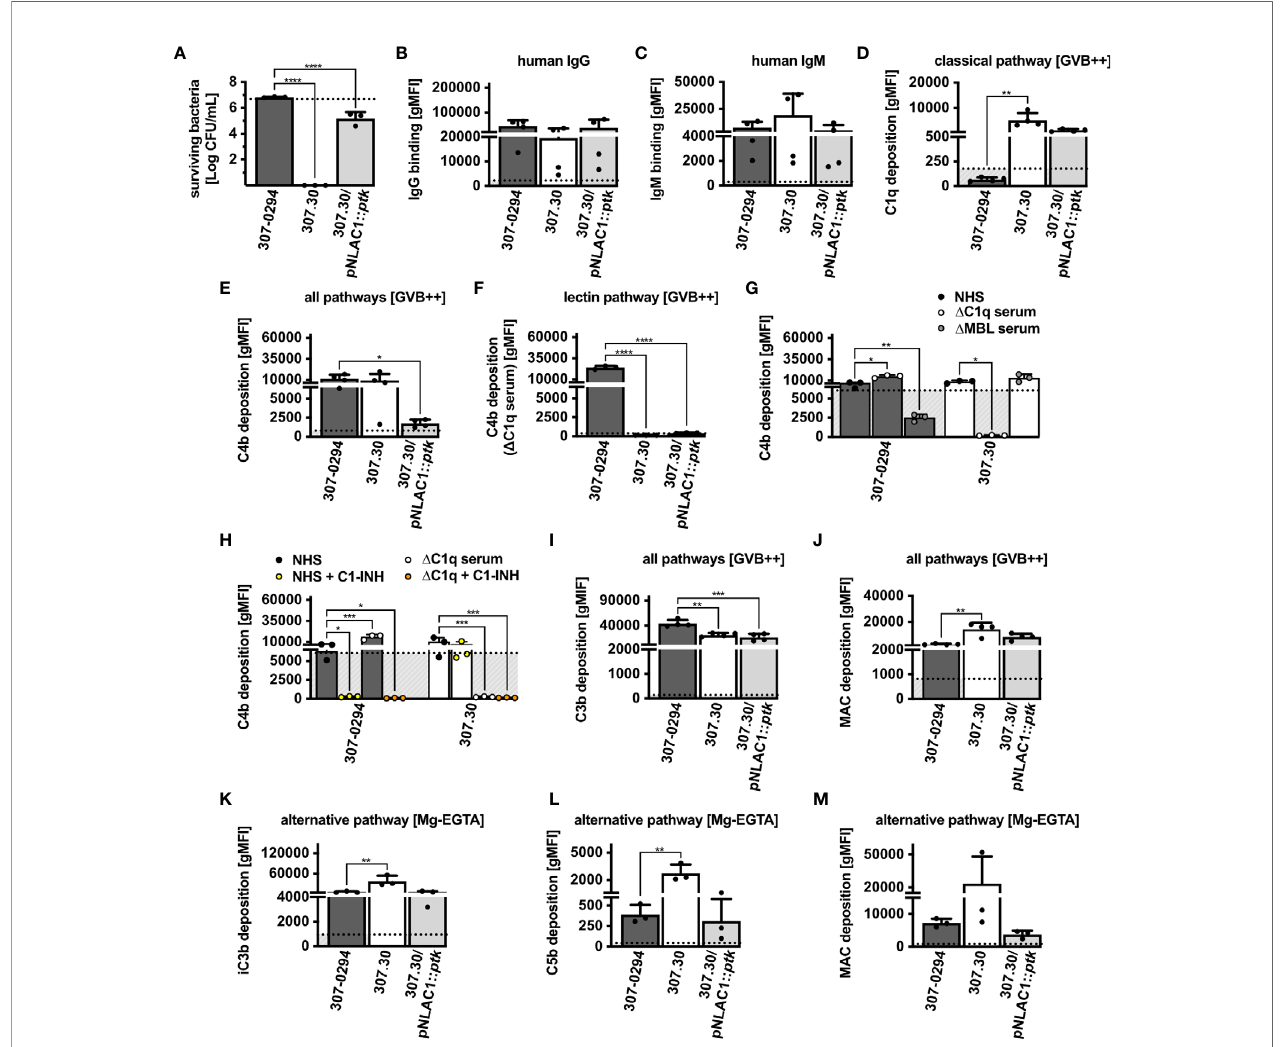
FIGURE 4 | Survival and complement system activation on A. baumannii mutant strains. (A) Survival of wt and capsule mutant strains in 30% NHS. Binding of human (B) IgG and (C) IgM. (D) Deposition of C1q. Deposition of C4b in (E) NHS, (F) human C1q-depleted serum, (G) NHS, human C1-depleted serum and MBL- depleted serum, (H) the presence of C1-INH. Deposition via all pathways of (I) C3b and (J) MAC and deposition via alternative pathway of (K) iC3b, (L) C5b and (M) MAC. (B – M) Bars represent gMFI ± SD of at least 3 independent experiments; horizontal dotted line represents gMFI (average + SD) measured in human sera with EDTA acting as a deposition control. One-way ANOVA with Dunnett ’ s post-test was used to analyze results from bactericidal activity assays and complement deposition assays, considering the parental AB307-0294 wt strain as control sample. Two-way ANOVA with Dunnett ’ s post-test was used to analyze results from C4b deposition assays in depleted sera, considering sample with NHS as a control sample. * p < 0.05, ** p < 0.01, *** p < 0.005, and **** p <